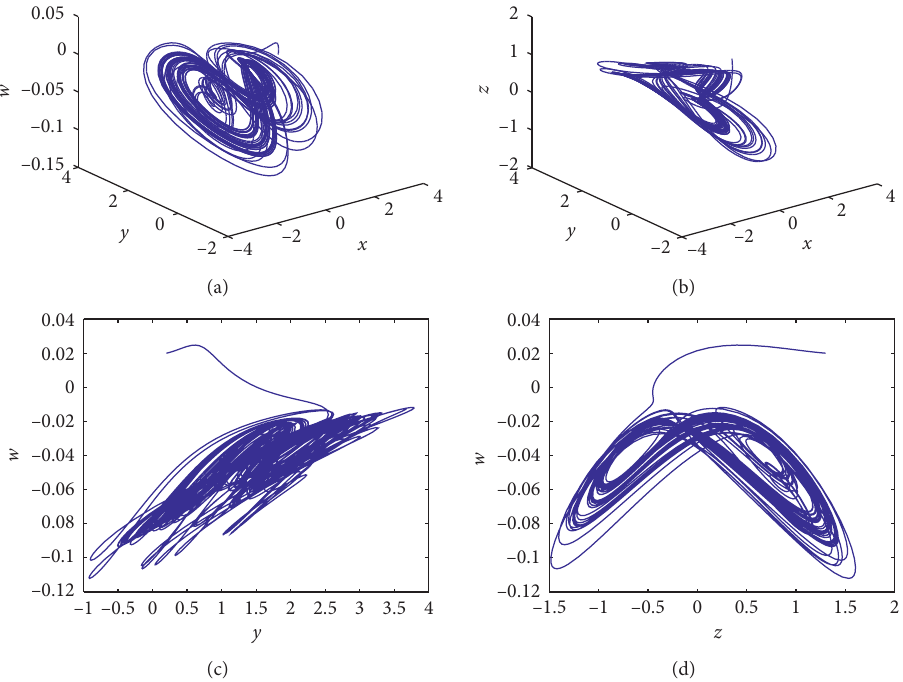
Figure 1: Simulation results of system (1) when a � 0.9, b � 0.1, c � 1, and r �− 0.6 (a) in the x-y-w space, (b) in the x-y-z space, (c) projected on the y-w plane, and (d) projected on the z-w